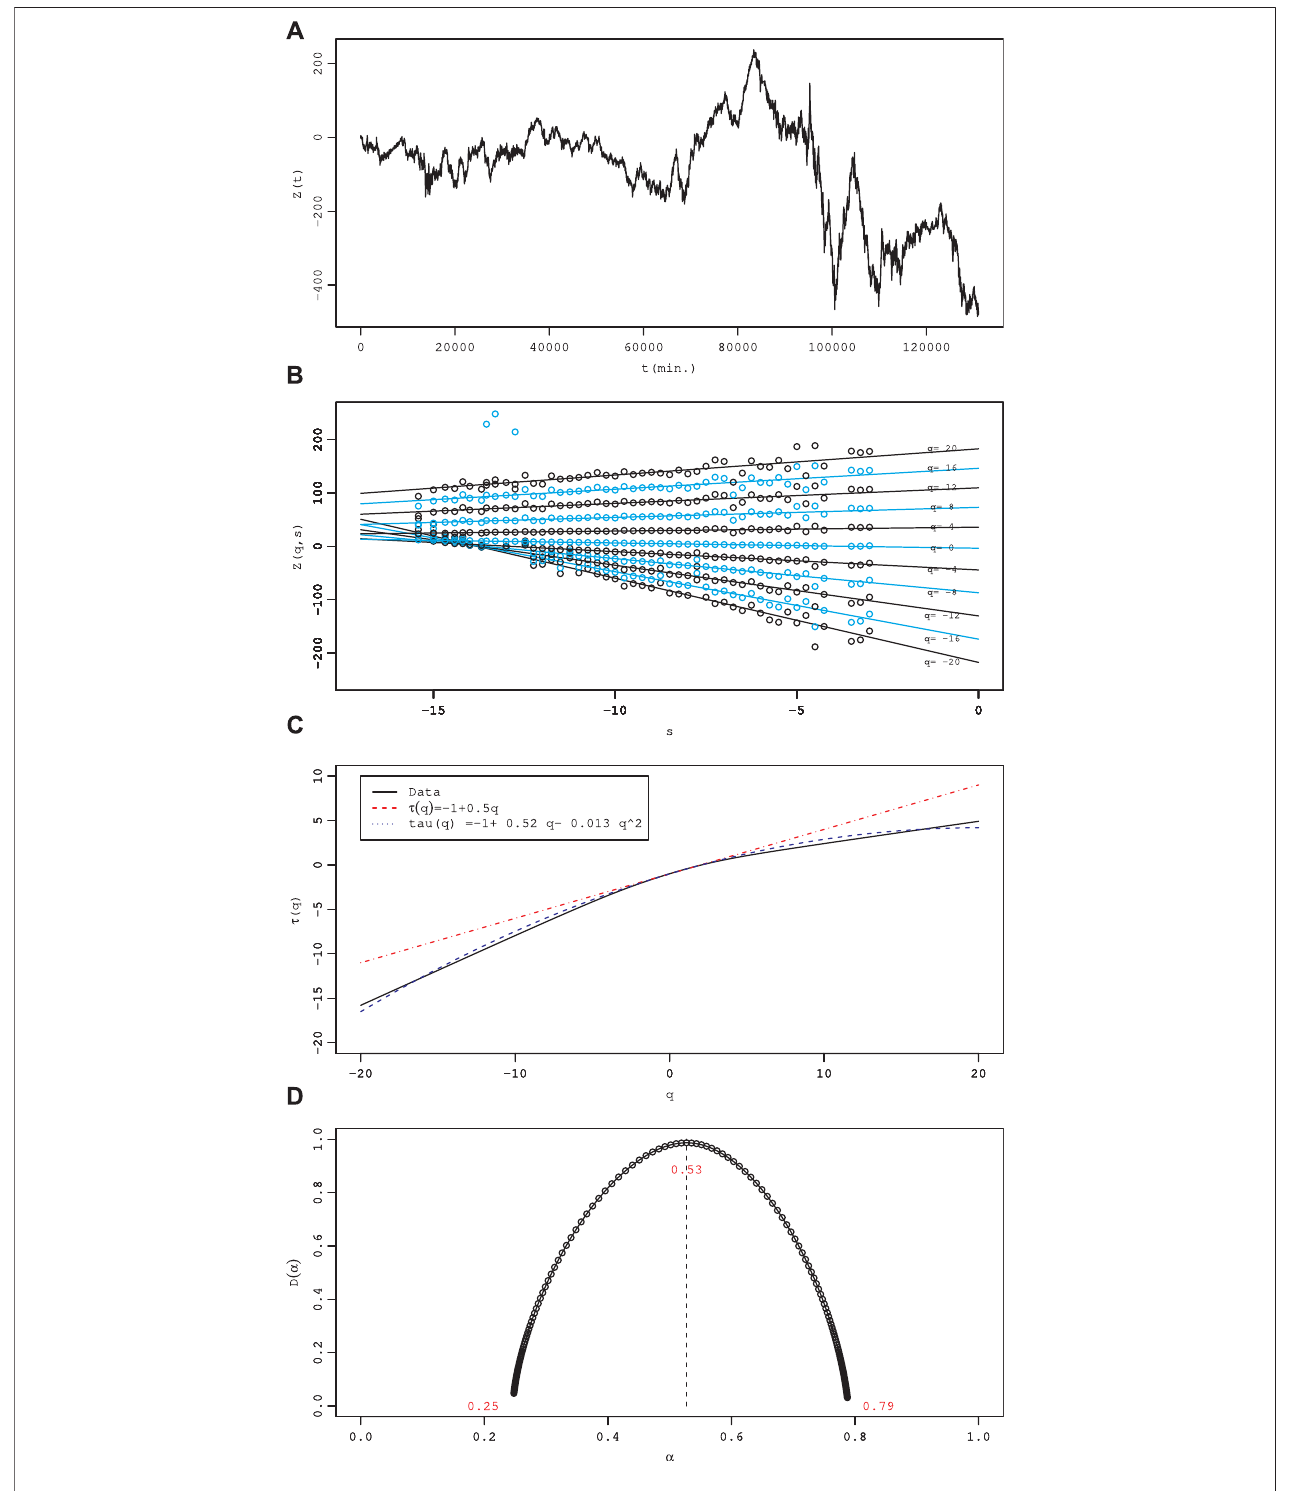
FIGURE2 | Results of multifractal analysis. (A) Z ( t ) . (B) Z ( q , s ) for q (cid:2) − 20 , ... , 20( + )and regression lines. (C) Scaling exponent τ ( q ) (solid line). The dashed blue line is the least-squares fi t to the quadratic function τ ( q ) (cid:2) − 1 + 0 . 52 q − 0 . 013 q 2 . The dotted red line τ ( q ) (cid:2) − 1 + 0 . 5 q corresponds to Brownian motion. (D) Singular spectrum D ( α )